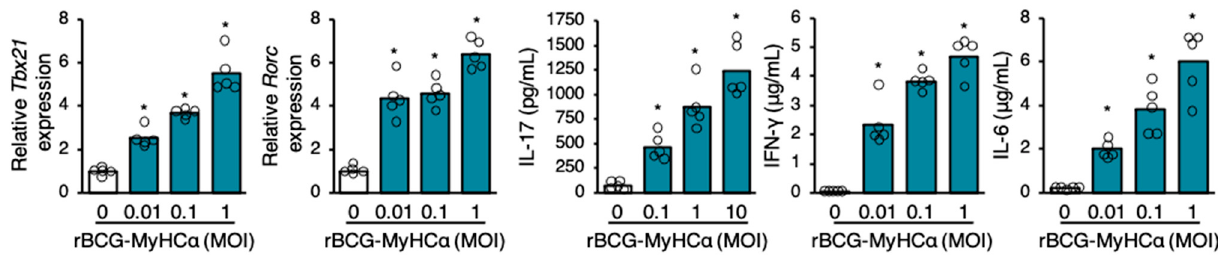
Figure 8. Culture supernatant of rBCG-MyHC α -infected DCs promoted Th1 and Th17 differentiation. Naïve CD4+ T cells were cultured in the supernatant of rBCG-MyHC α -infected BMDCs for 48 h. The gene expression of Tbx21 and Rorc were assessed by qRT-PCR and cytokine concentrations in the culture supernatant were assessed by ELISA. The values are expressed as means of pentuiplicate wells. * p < 0.05 vs. MOI 0 by one-way ANOVA with Tukey’s post hoc test.